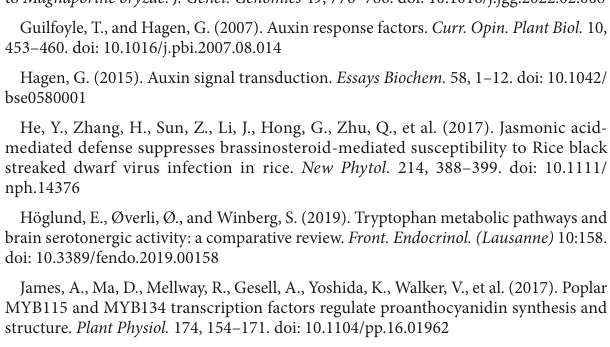
SUPPLEMENTARY FIGURE 1 The mutations of 17case plants. (A) The mutants of OsARF17 with the nucleotide deletion were shown by red letters. 17cas-2-1 mutant harbored a deletion of TC and 17cas-5-2 with a deletion of TCACA, which generating a frameshift mutation leading to a premature stop codon. (B) Schematic diagram of the full-length and OsARF17 truncated. Three complete domains of OsARF17 in (A) were truncated. DBD: DNA-binding domain; MR: middle region; CTD: carboxy-terminal dimerization